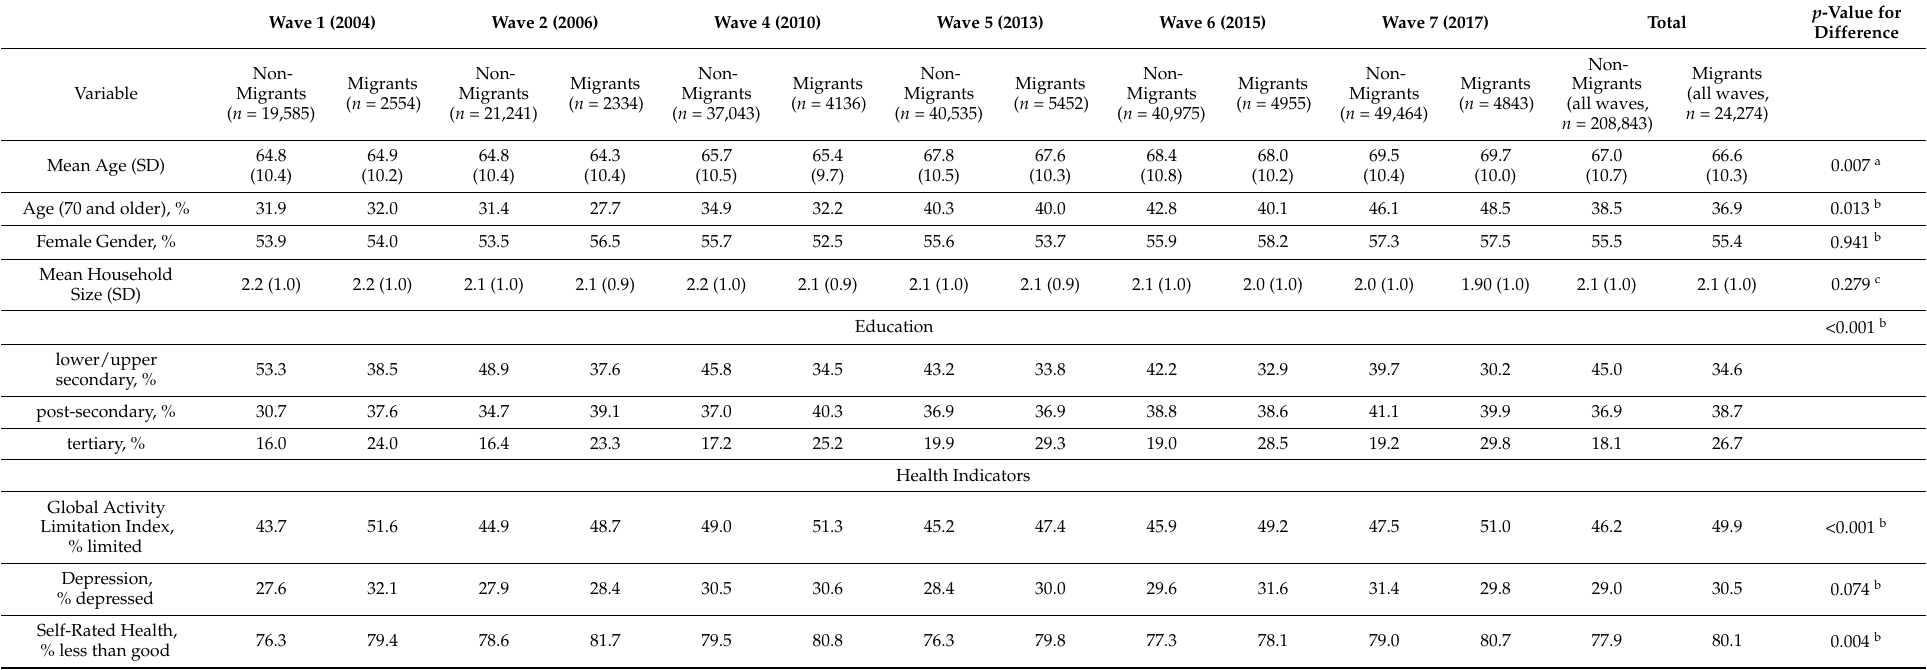
Table 1. Descriptive statistics of SHARE data ( n = 233,117; across all countries and